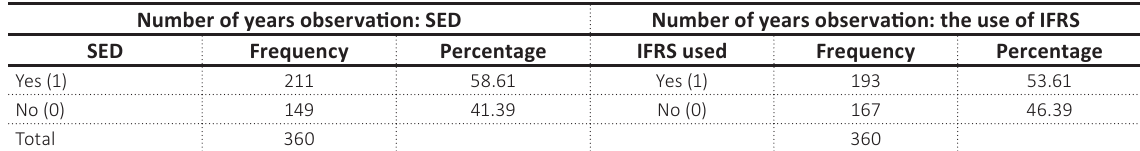
Table 2. SED description and the use of IFRS (2010–2018)